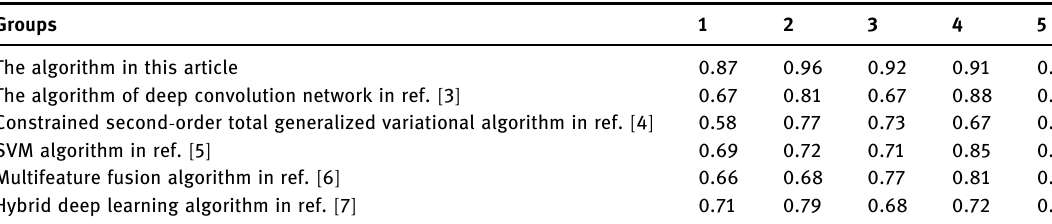
Table 2: SSIM values of di ff erent methods